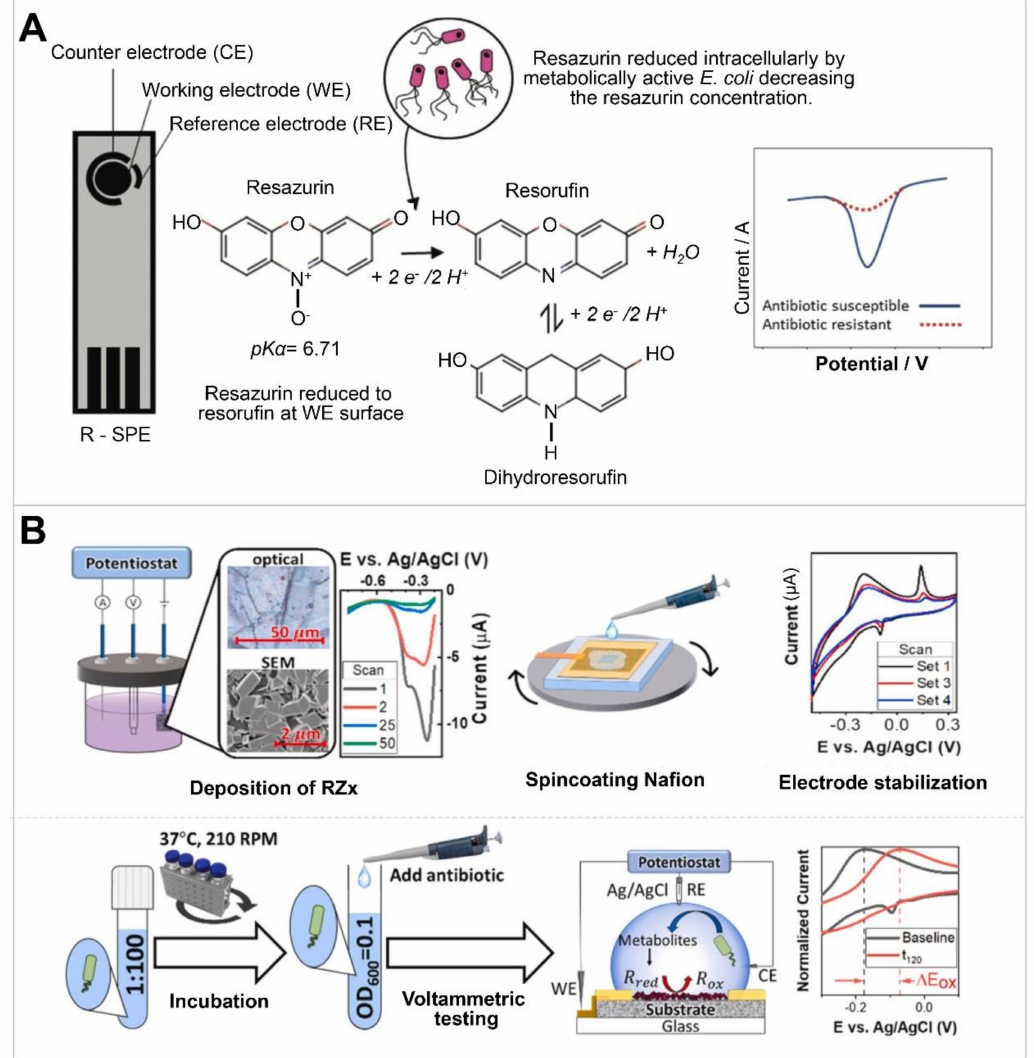
Figure 4. Electrochemical antibiotic susceptibility testing strategy based on the change in the redox state of the redox-active reagent affected by bacterial metabolism: ( A ) Resazurin-containing screen- printed carbon-graphite electrode for the AST of E. coli against gentamycin. Adapted with permission form [61]. Copyright 2021 RSC.: ( B ) Nafion-coated resazurin-active crystal layers (RZx) on a planar pyrolytic graphite electrode for the AST of E. coli against ampicillin and kanamycin. Adapted with permission form [63]. Copyright 2021 Biosensors and